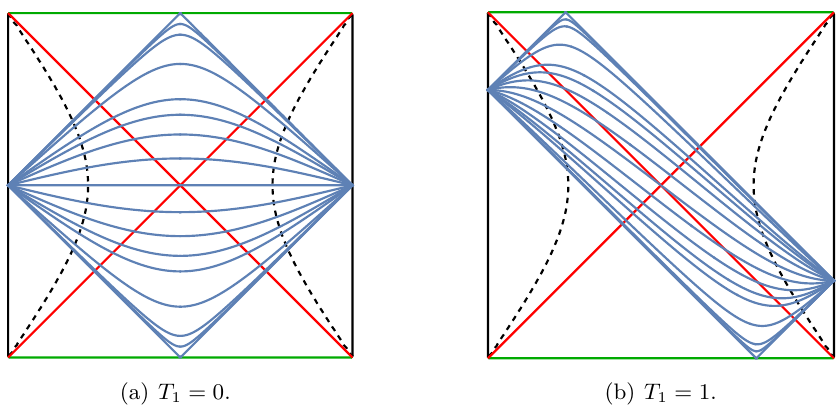
Figure 1 . Penrose diagram for (half of) dS 2 with geodesics in blue. The horizons are drawn in red, and past and future infinity are in green. In dashed black, we also plot the position of stretched